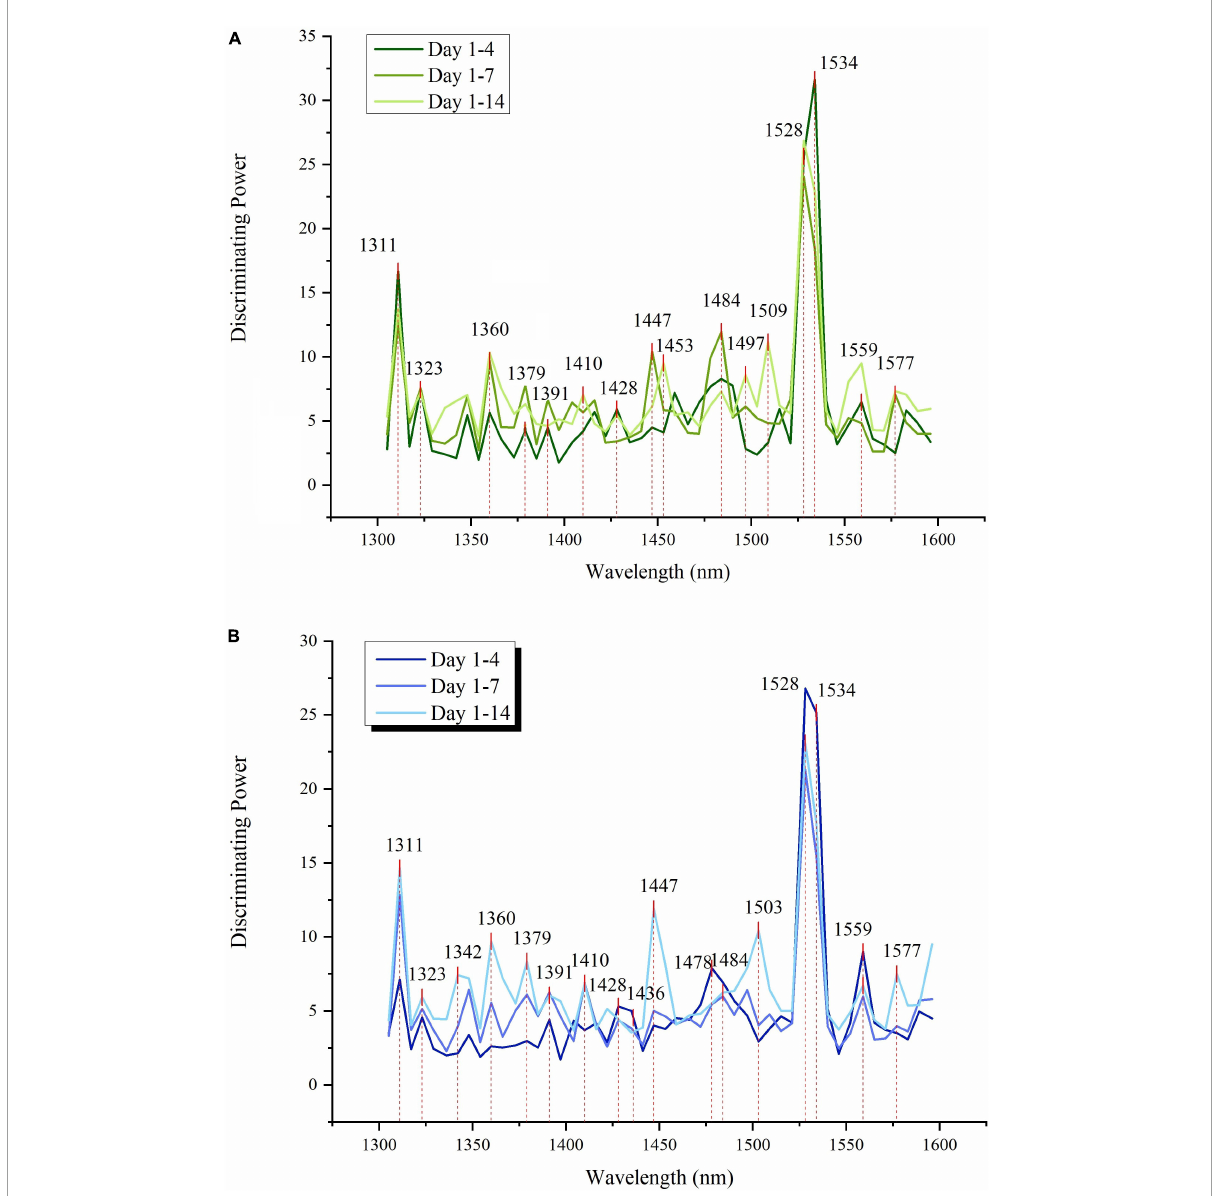
FIGURE5 Soft independent modeling of class analogies (SIMCA) discriminating powers of absorbance bands show the importance of individual variables in NIR spectra for discrimination between the storage days of strawberries during 4, 8, and 15 days of storage (A) SIMCA results for CF group (B) SIMCA results for SCF